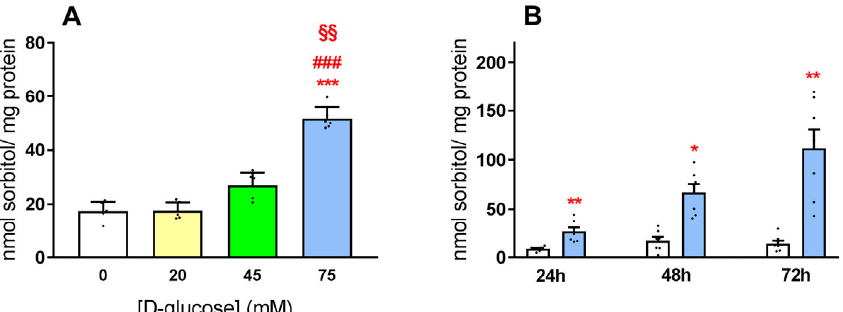
Figure 2. Intracellular sorbitol accumulation in HLE cells exposed to high glucose conditions. Intracellular sorbitol content was fluorimetrically measured, as described in Section 2.6. ( A ) HLE cells were grown for 48 h in MEM supplemented with the indicated D-glucose concentrations. Values are reported as the mean ± SEM of six independent measurements. Statistical analysis was performed using one-way ANOVA with Tukey post hoc test. Significance of the 75 mM D-glucose treatment was evaluated with respect to the following conditions: no treatment: *; 20 mM D-glucose treatment: #; 45 mM D-glucose treatment: §. ( §§ : p < 0.01 value; ***, ### : p < 0.001). ( B ) Cells were incubated for the indicated times in MEM alone (white bars) or supplemented with 75 mM D-glucose (blue). Values are reported as the mean ± SEM of seven independent measurements. Statistical analysis was performed using Student’s t -test. Significance was evaluated with respect to untreated cells incubated for the same time (*: p < 0.05; **: p <